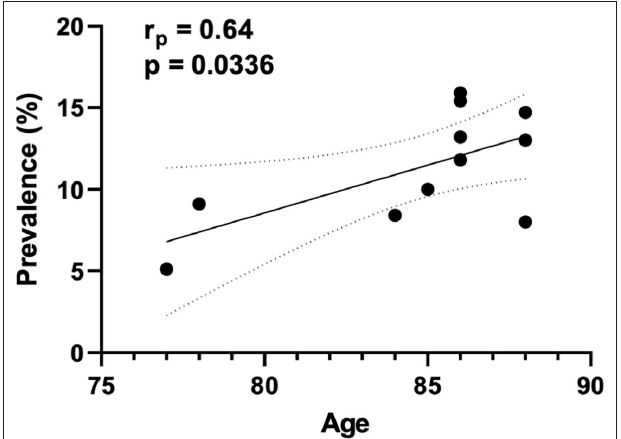
FIGURE 2 | Correlation between the prevalence of CA and age. The correlation plot indicates the results of 11 studies. The abscissa (x axis) represents the mean age of patients with both conditions (CA and AS), while the ordinate (y axis) represent the prevalence of CA in each included study.